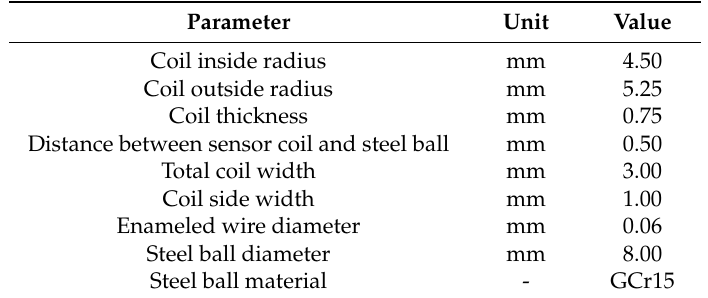
Table 1. Parameters of the sensor coil.